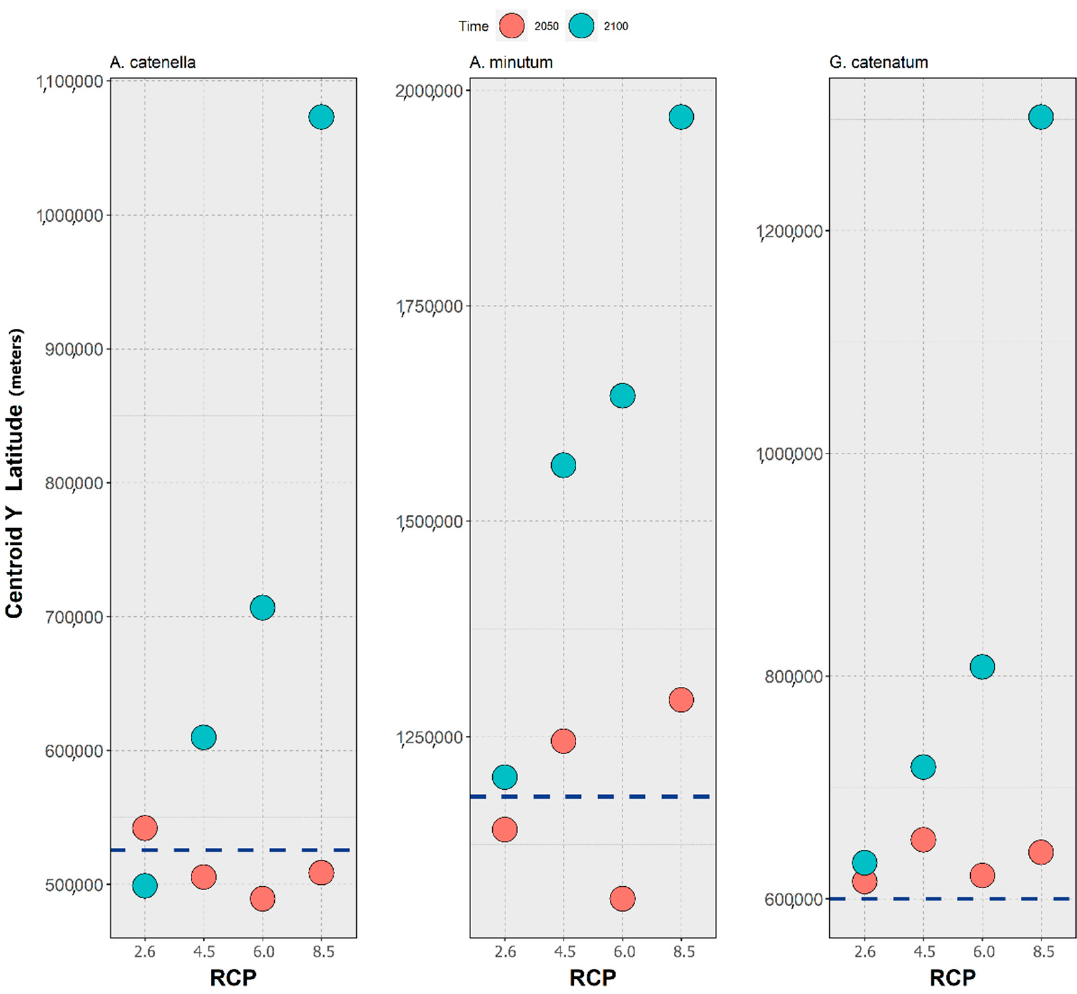
Figure 1. Changes in the centroid of latitudinal distribution (i.e., the mean latitude of the occupied pixels) calculated for 2050 (red circles) and 2100 (blue circles) and Representative Concentration Pathway scenario (RCP-2.6, 4.5, 6.0, and 8.5; CMIP5) for each of the three PST-producing HAB species ( A. catenella —left , A. minutum —centre, and G. catenatum —right). The dark blue, dashed horizontal lines represents the centroid value for the present-day (2000–2014 environmental conditions based on monthly averages).